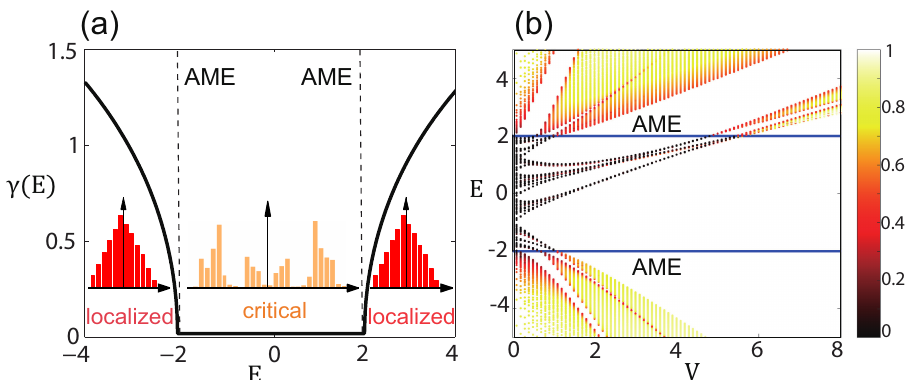
Figure 1: Anomalous mobility edge in an unbounded quasiperiodic potential. (a) Lyapunov exponent versus energy for the model of Eqs. (1) and (2), as found analytically [ Eq. (5) ] . The Insets show cartoons of localized and critical states in the corresponding phases. (b) Inverse participation ratio IPR versus potential amplitude and energy for the same model, as found using numerical calculations. The solid = ± blue lines show the AMEs at E m